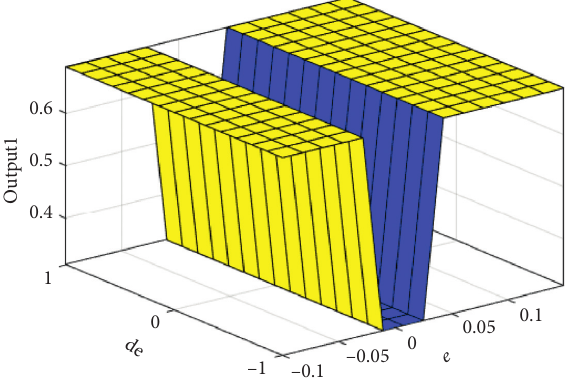
Figure 6: Surface viewer for rule base.